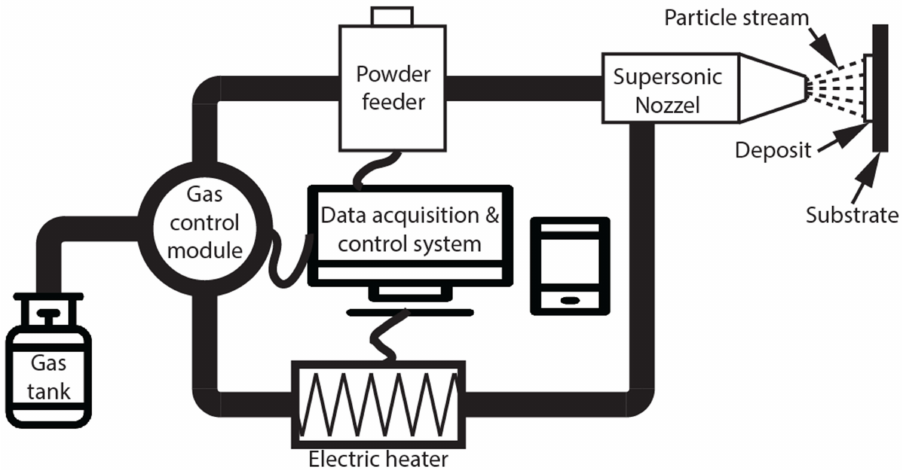
Figure 1. Schematic of the cold-spray technology.